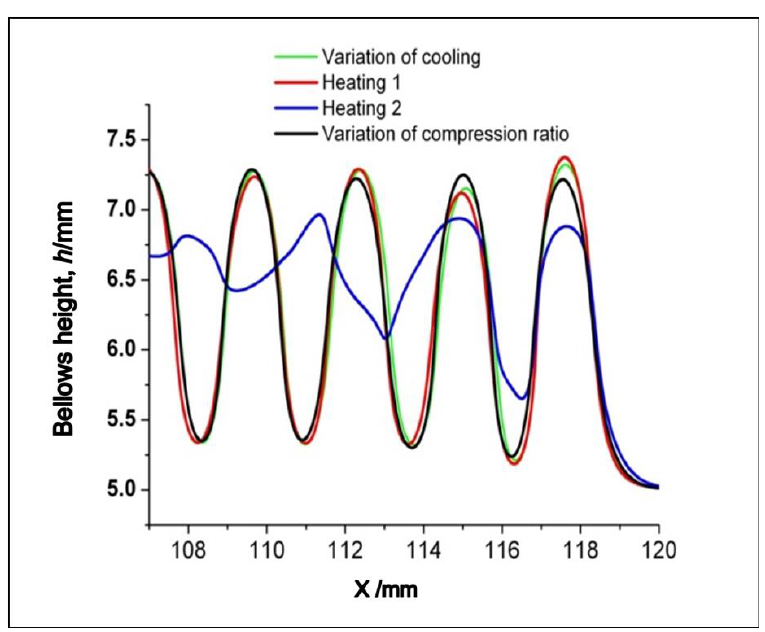
Figure 8. Results of the heating and the compensation of the compression speed to various cooling.